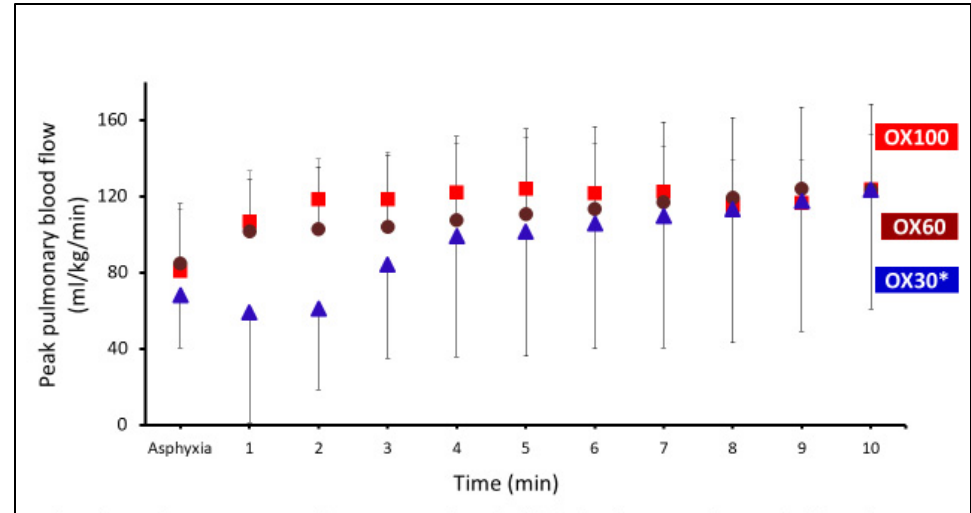
Figure 4. The graph shows the peak left pulmonary blood low (PBF) in ml/kg/min on the y ‐ axis and the events in min on the x ‐ axis. The PBF was significantly lower in the OX30 (triangle) group (* p = 0.012 by ANOVA). Data are represented as average and standard deviation.